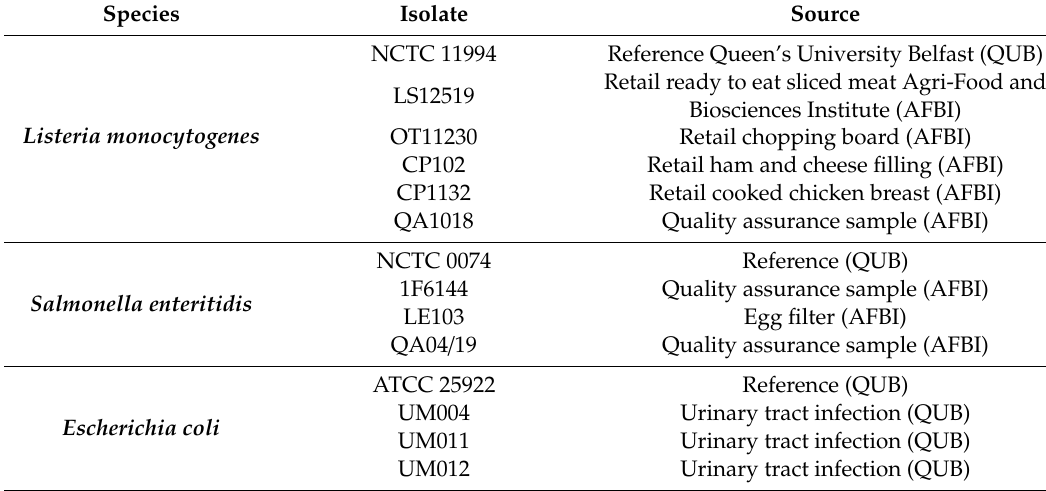
Table 1. Reference strains, clinical isolates, and their